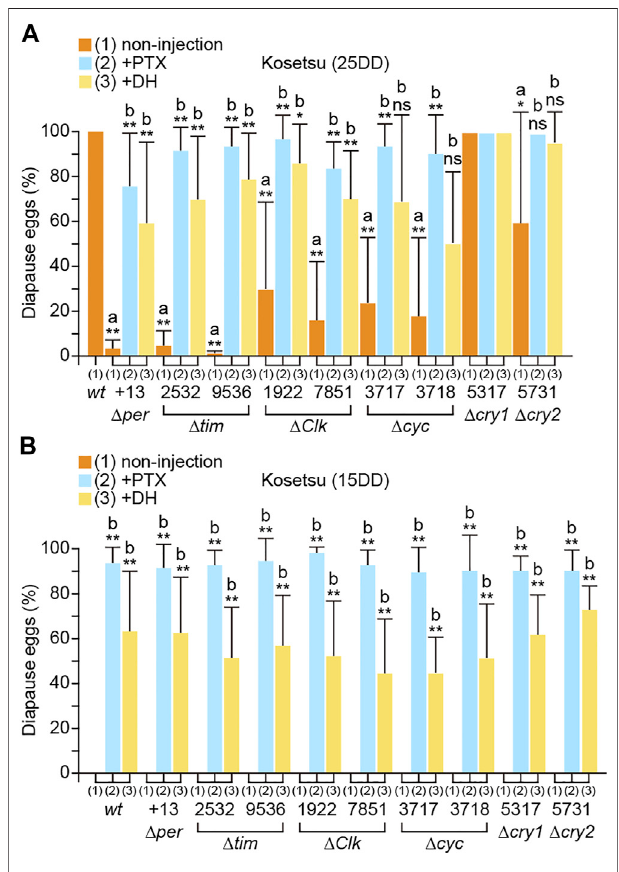
FIGURE 2 | Disruption of temperature-dependent diapause induction in clock gene knockout mutants. wt eggs were incubated under constant darkness (DD) at 25 ° C [25DD] (A) or DD at 15 ° C [15DD] (B) . Diapause egg- inducing activities were measured in progeny eggs (non-injection). For rescue experiments, both wt and knockout mutants were injected with picrotoxin (PTX; 50 μ g; +PTX) 1 day after pupation or with diapause hormone (DH; 100 pmol; +DH) 3.5 days after pupation, and the percentages of diapause and non-diapause eggs were determined. Each bar represents mean ± standard deviation (SD) of 20 – 30 animals. Statistical differences were examined by the Steel – Dwass test between each non-injected knockout mutant and wt (A) and between injected and non-injected treatments in each knockout mutant (B) . ns, non-signi fi cant; *, p < 0.05; **, p < 0.01.